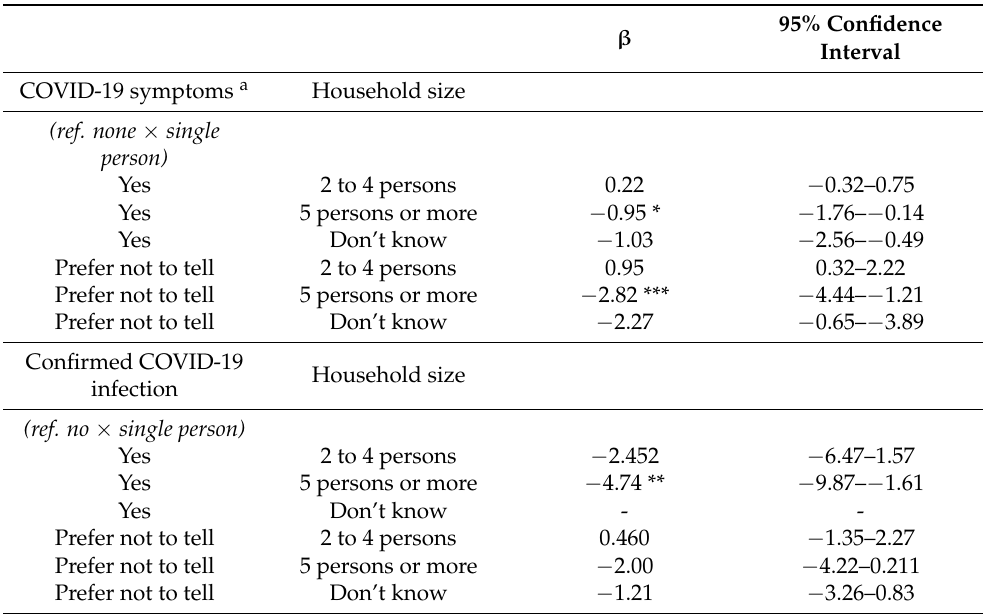
Table 2. Interactions between COVID-19 symptoms, confirmed COVID-19 diagnosis, and house- hold